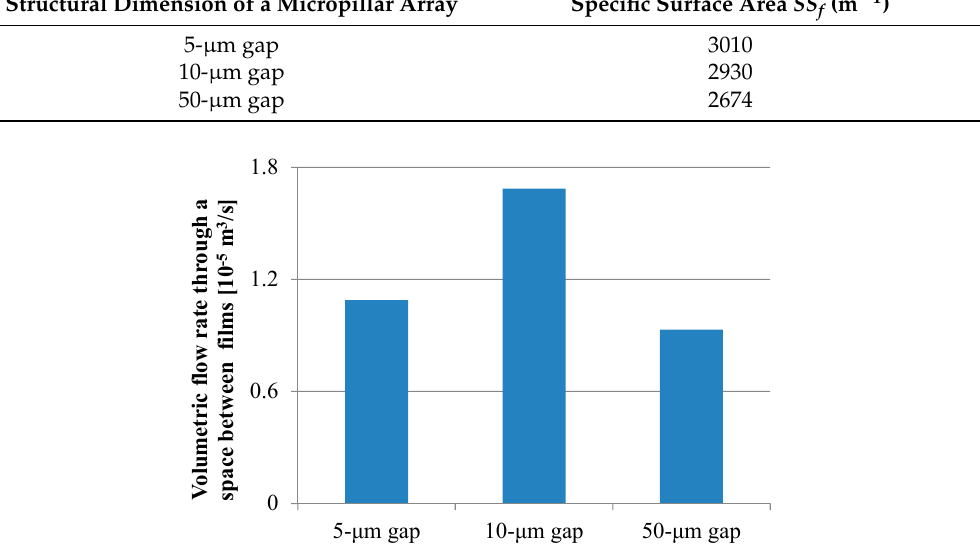
Figure 9. Volumetric flow rate through a space between films calculated using Equation (10).